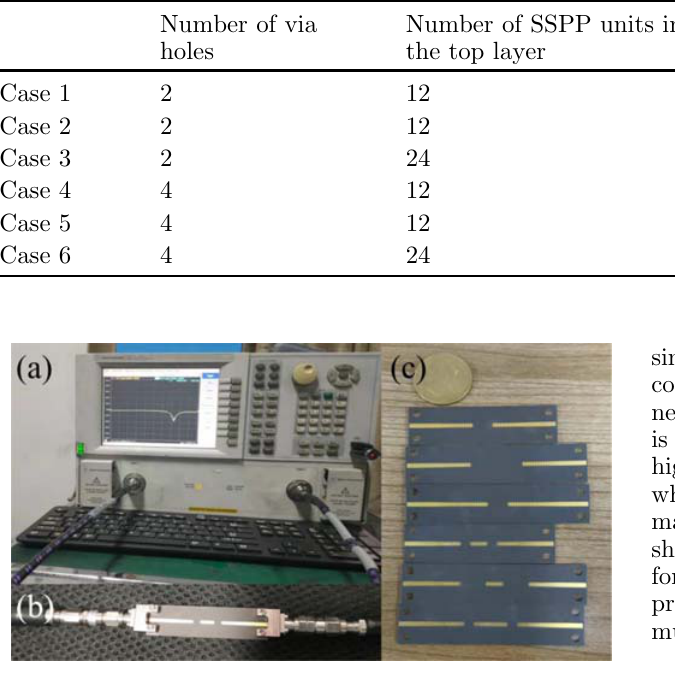
Fig. 5. (a, b) The test system of the experiment. (c) The measured samples of the 6 cases. The samples of case 1 to case 6 are arranged in order from the top to the bottom of the photo.